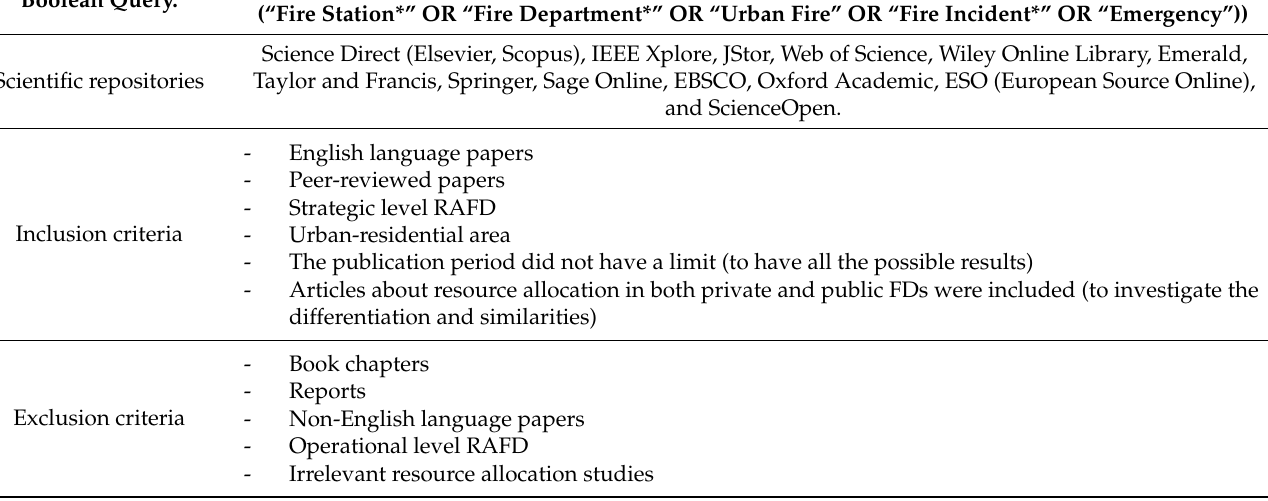
Table 1. The SLR’s search phrase, science databases and inclusion-exclusion criteria. Boolean